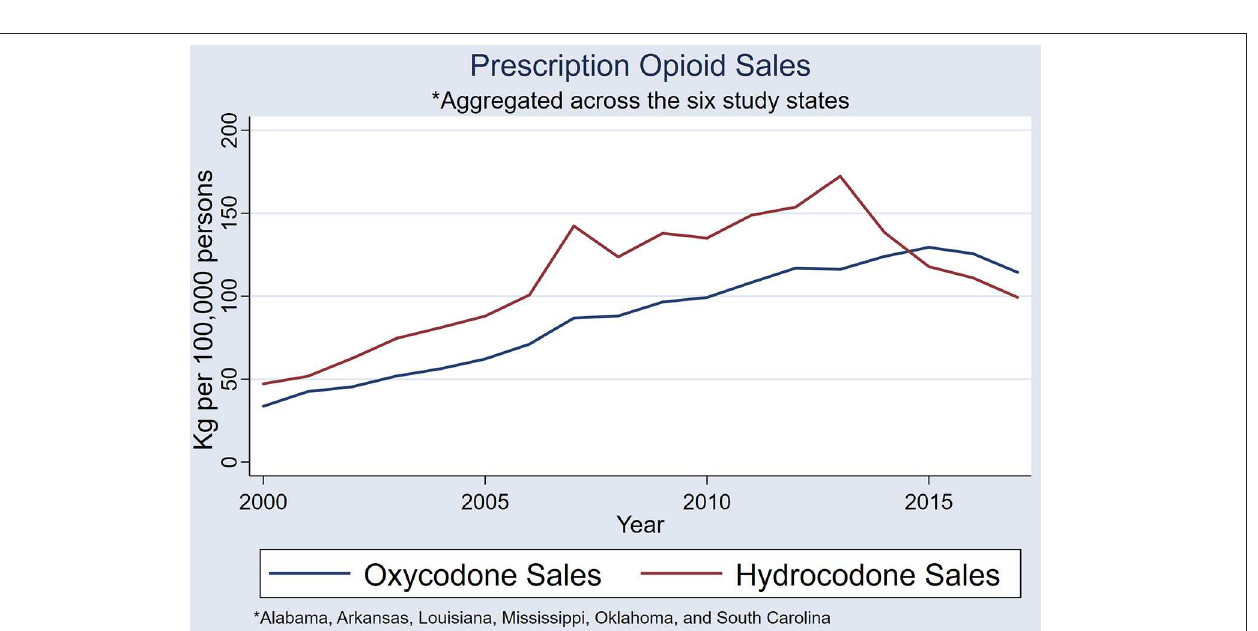
FIGURE 7 | A comparison of state-aggregated (Alabama, Arkansas, Louisiana, Mississippi, Oklahoma, and South Carolina) hydrocodone and oxycodone sales (kilograms per 100,000